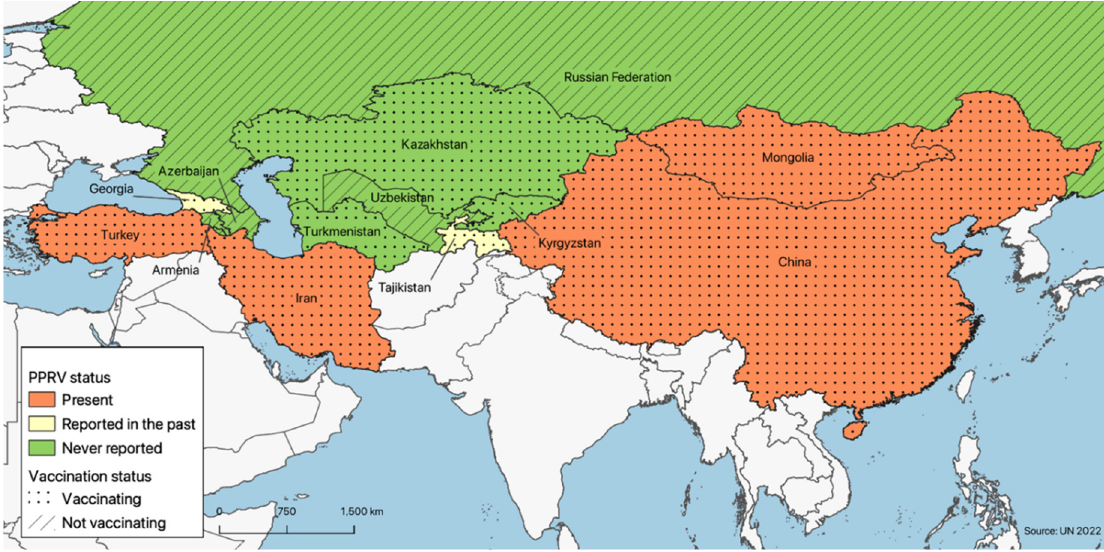
Figure 2. Map of the region under consideration showing each country’s PPR epidemiological and current vaccination status, retrieved respectively from OIE WAHIS and from Roadmap meetings. See main text for further